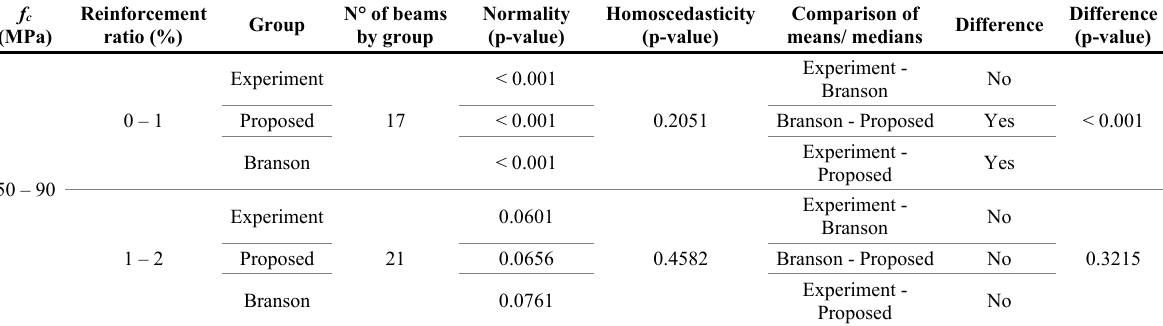
Table 2. Beams analysis with f c from 50 to 90 MPa with reinforcement rate from 0 to 1% and reinforcement rate from 1% to 2%. f c